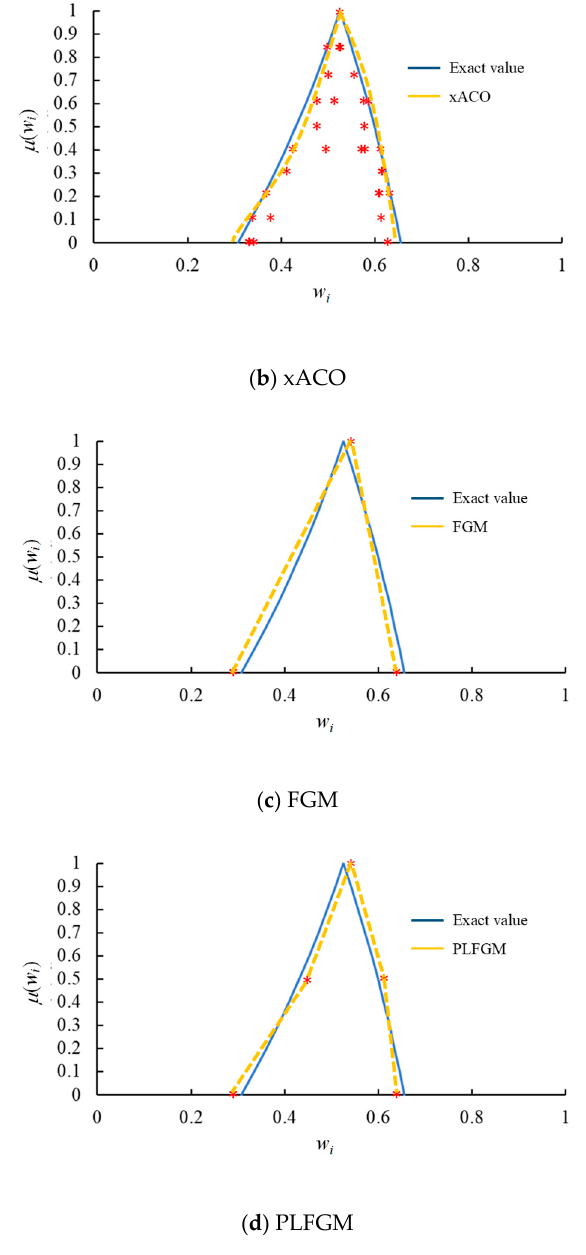
Figure 4. Differences among ACO, xACO, FGM, and PLFGM (* denotes a data point) ( a ) ACO; ( b ) xACO; ( c ) FGM; ( d ) PLFGM.